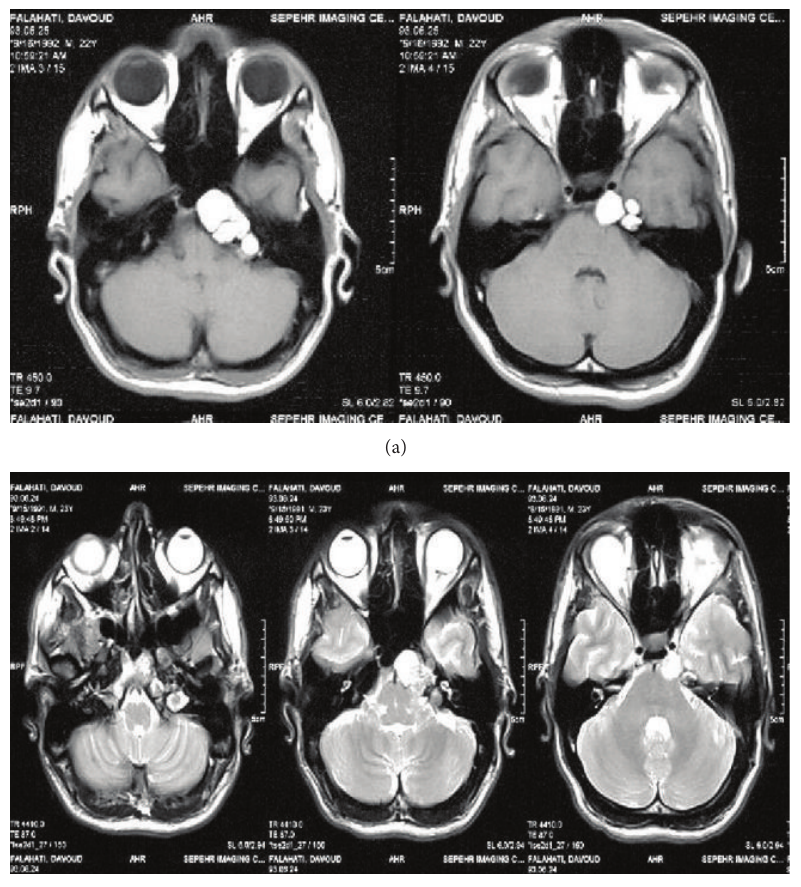
Figure 5: (a) T1 weighted MRI shows the cholesterol granuloma involving the right petrous apex. (b) Axial T2 weighted MRI shows the residual tumor at petrous apex adjacent to right carotid